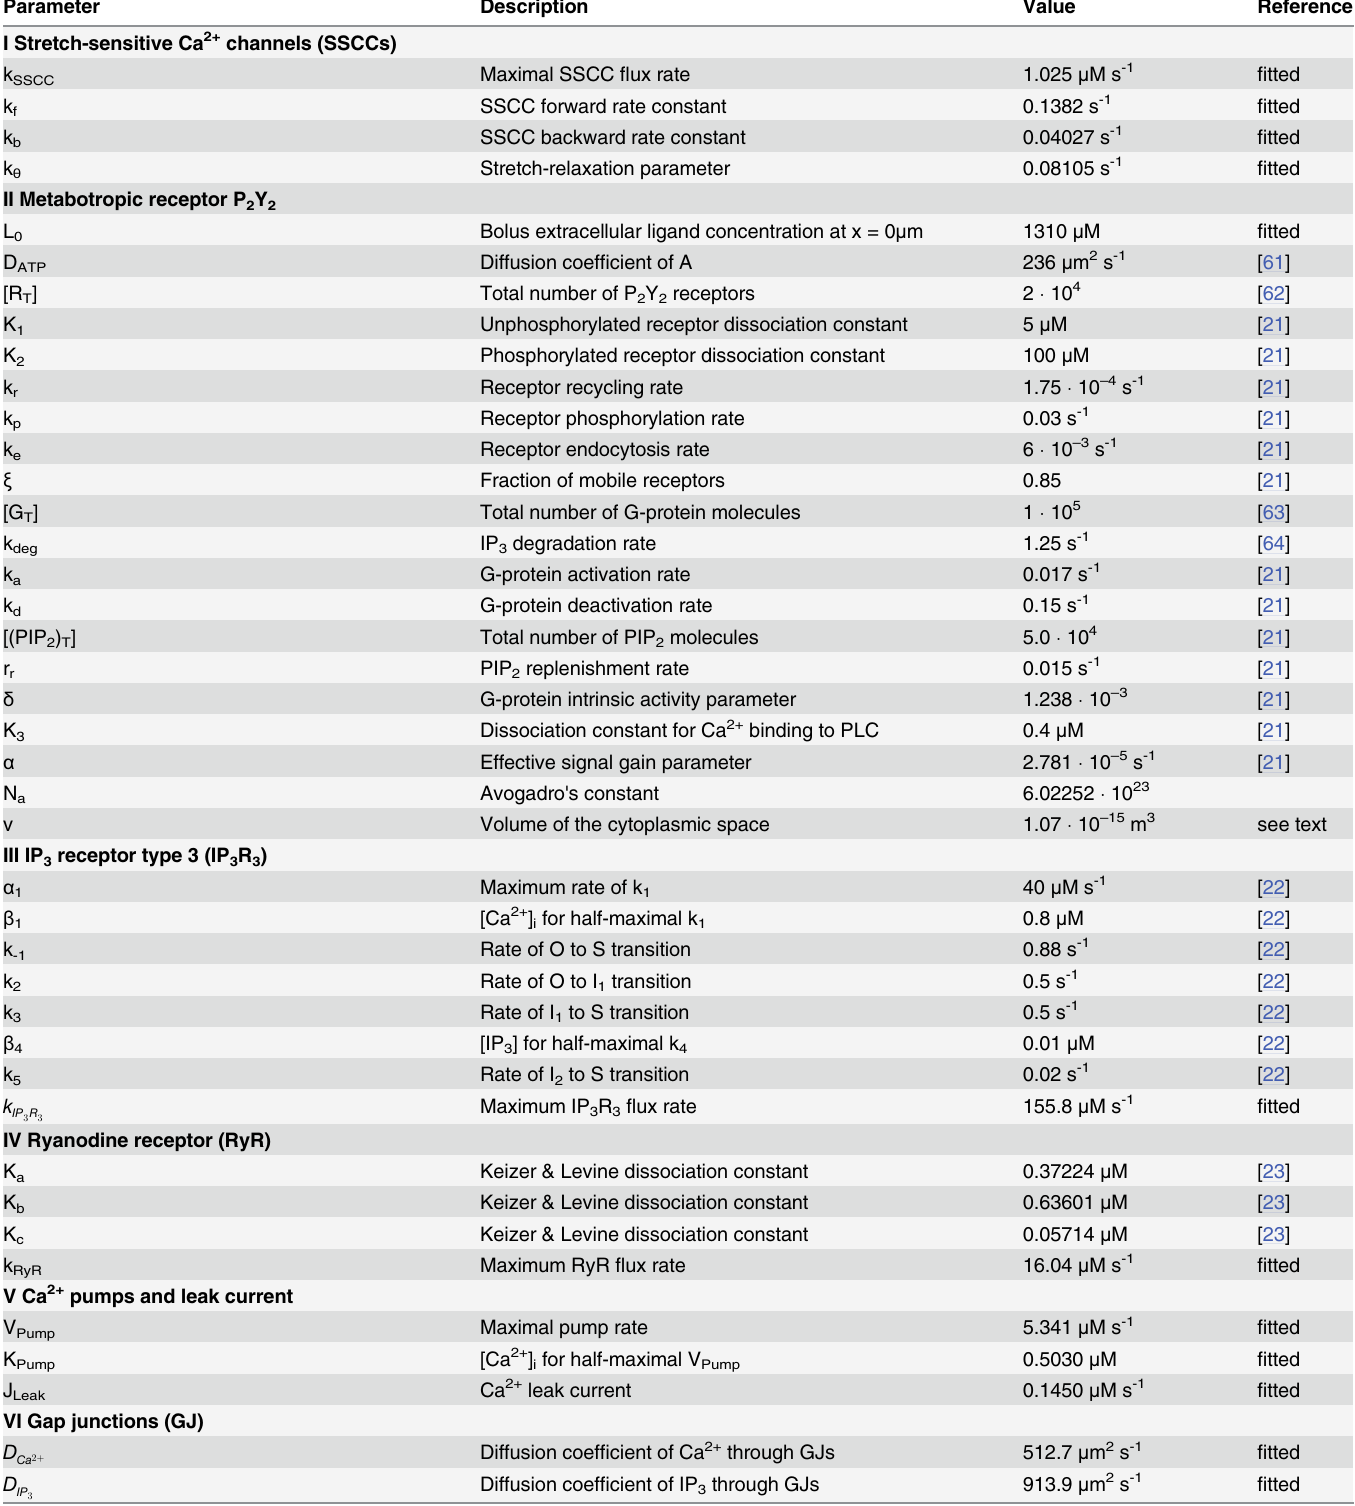
Table 2. Constant parameters and initial